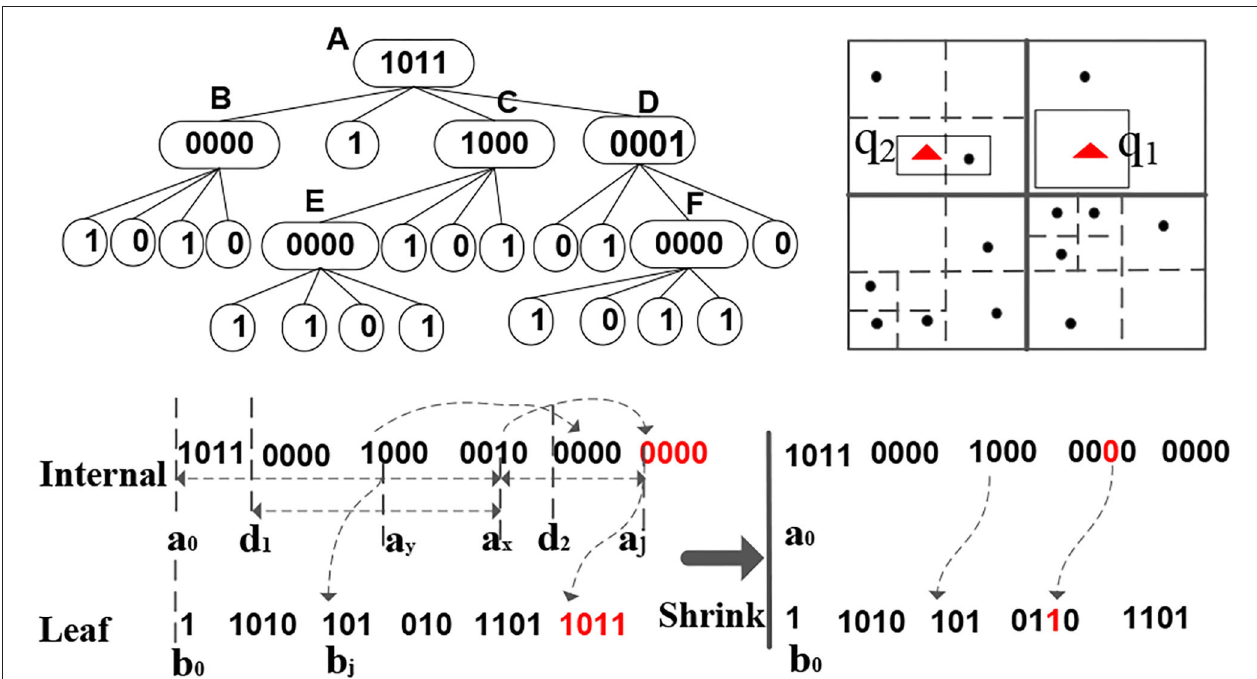
FIGURE 4 | sFilter structure (up left), the related data (up right), and the two bit sequences of the sFilter